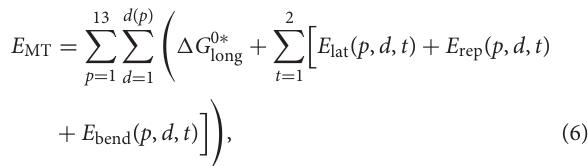
Every tubulin monomer has four interaction points: